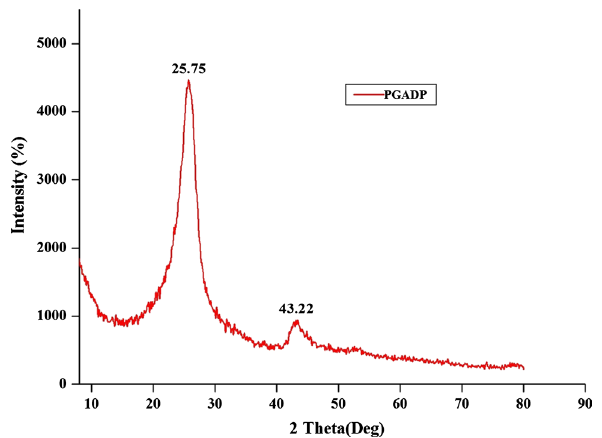
Fig. 4 XRD spectra of PGADP